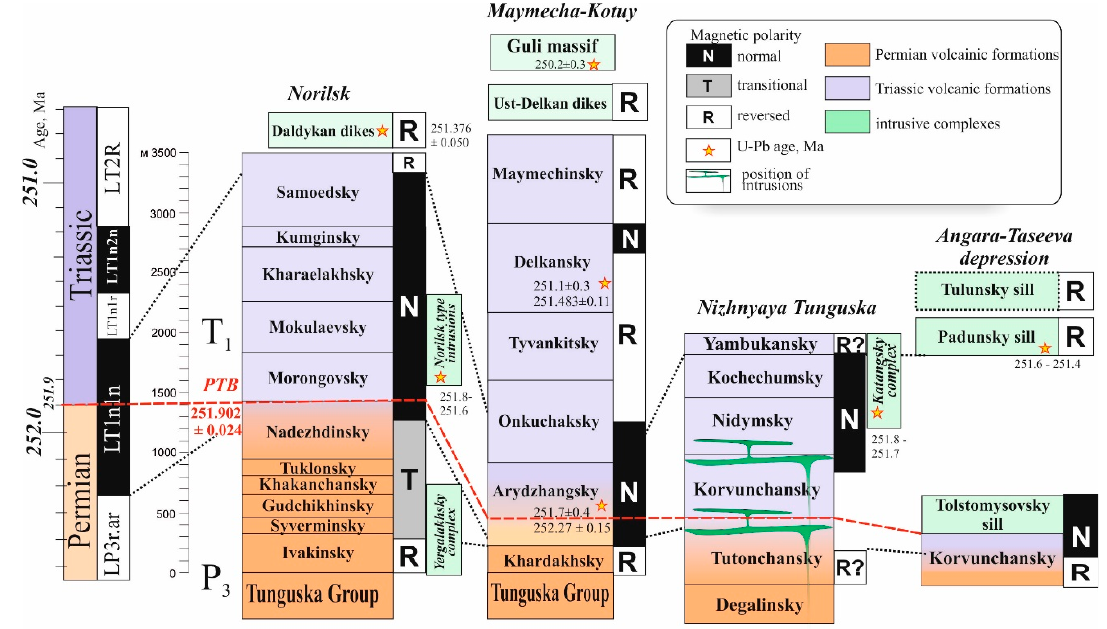
Figure 9. Correlation scheme for regions of the Siberian Traps LIP. After [42], with changes. U-Pb data from [15,29,47]. Magnetic polarity data after ([33,41,42,49,63,64,80] this study). Chrons of Global Polarity Timscale after [66–68].